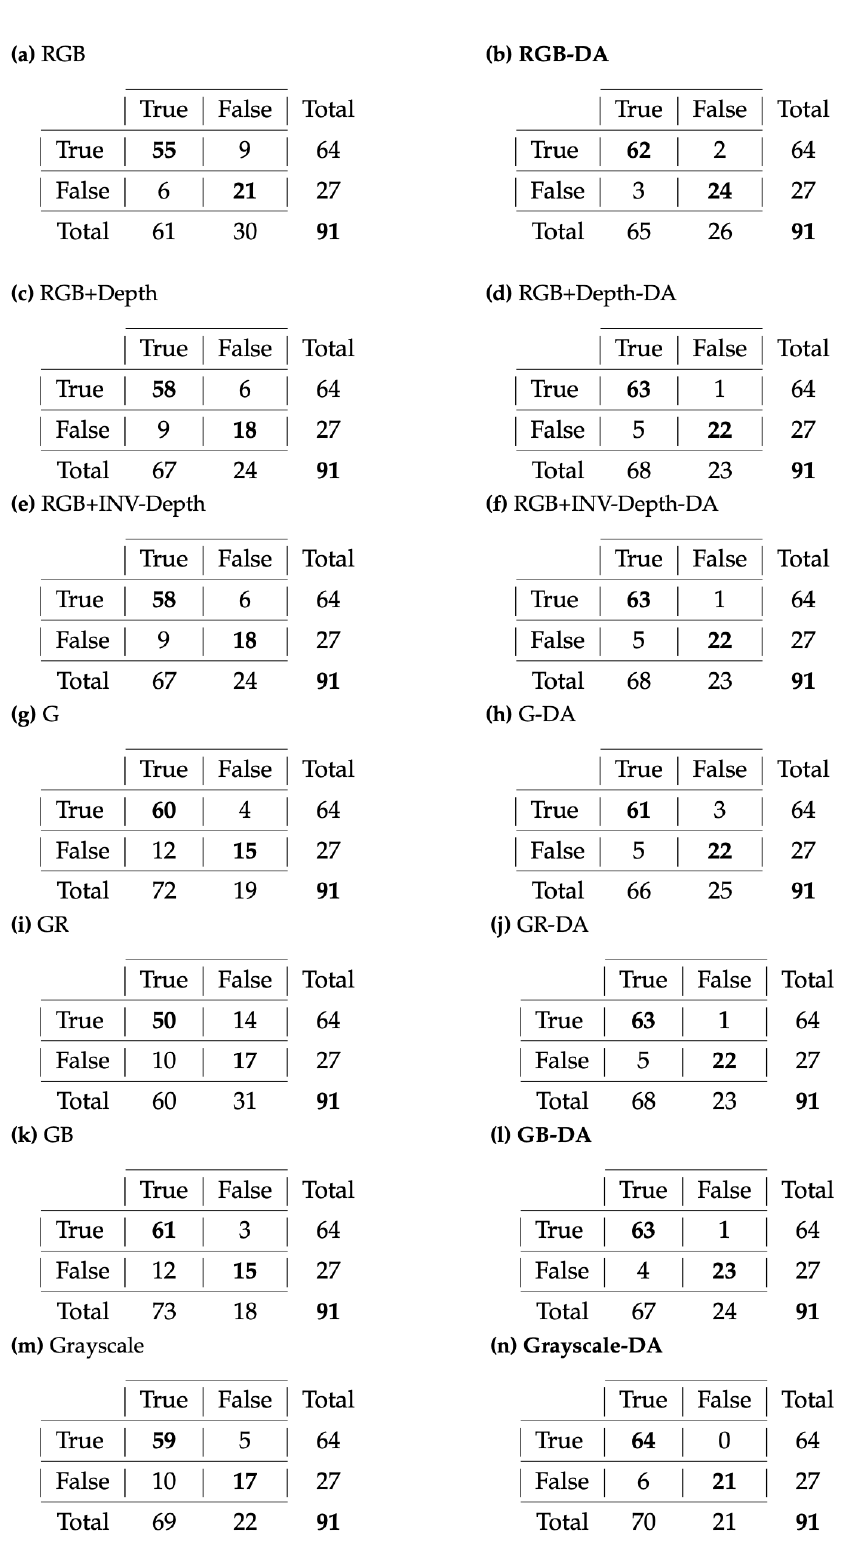
Figure 9. Confusion matrices from some results; ( b , l , n ) are the best